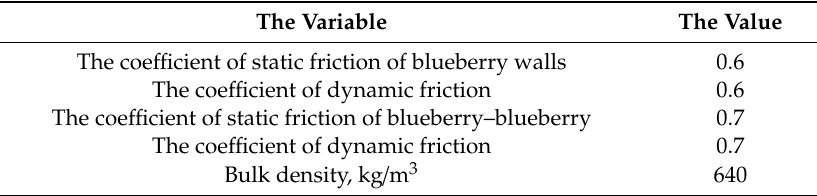
Table 1. Summary of selected physical properties of blueberry fruit used in the